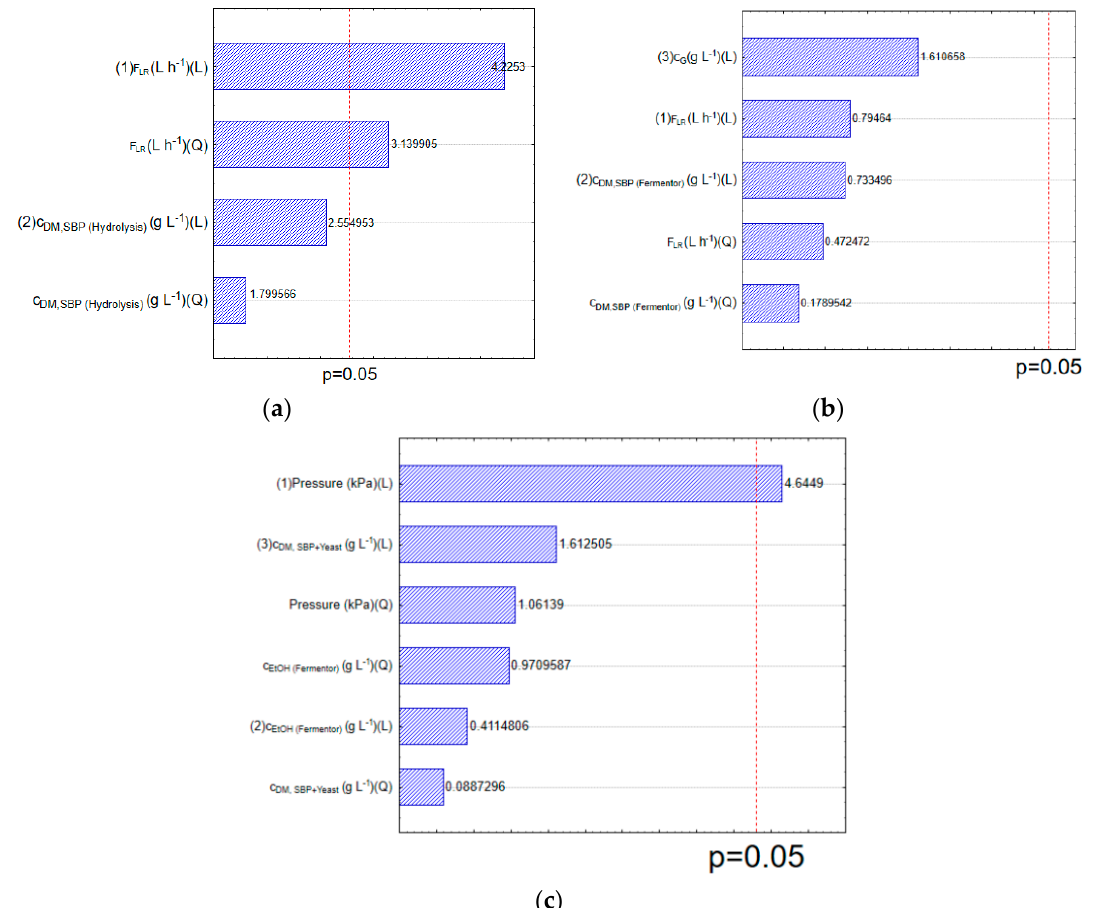
Figure 6. Pareto charts for the effects of the vacuum ratio, recycling ratio and sugar beet pulp (SBP) concentration in the: hydrolysis step ( a ); fermentation step ( b ) and vacuum stripping step ( c ).